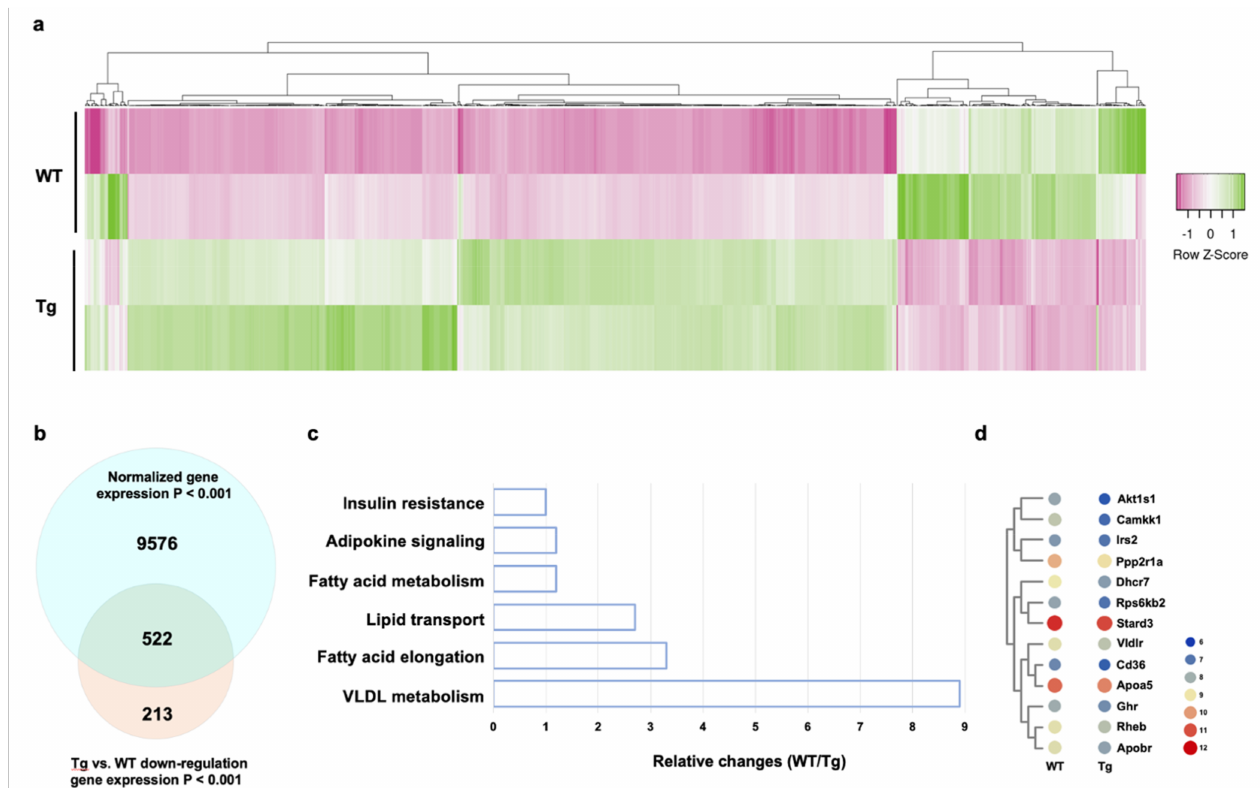
Figure 4. Whole-genome microarray analysis of transcriptomic profiles of miR-29aTg and wild-type bone marrow mes- enchymal cells. Heatmap showing differential gene transcription of miR-29aTg and WT cells ( a ). Venn diagram showing 213 gene transcription repression in miR-29aTg cells ( b ). KEGG pathway analysis revealed that miR-29a downregulated gene transcription, which involved fat, fatty acid, lipid transport, and lipoprotein metabolism ( c ). Heatmap of transcriptome involving fatty acid and lipid metabolism ( d ). Microarray analysis was performed in 3